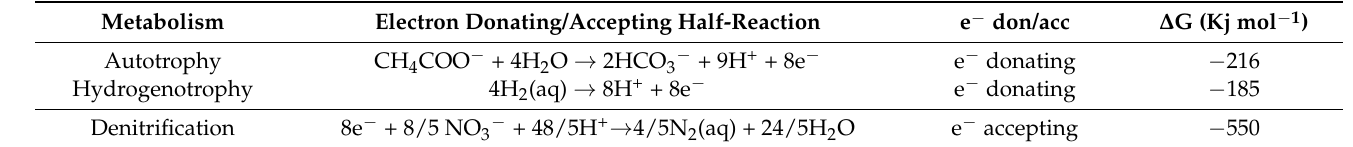
Table 2. Half-reactions of electron donors and electron acceptors with their energy productions in anoxic environments (Used with permission from